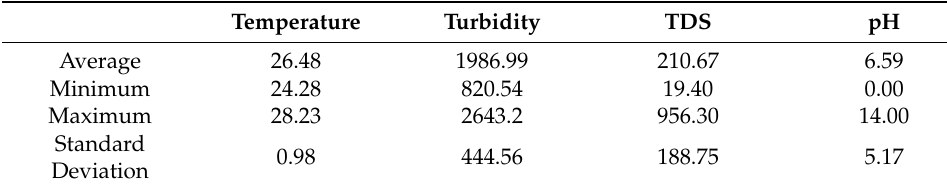
Figure 9. Temperature variation. Table 5. Summary of